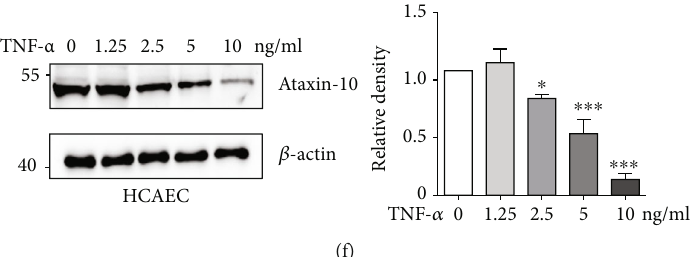
Figure 1: Expression of Ataxin-10 in endothelial cells. (a) Representative images of Western blotting for detection of the expression of Ataxin-10 in mouse tissues including adipose, aorta, brain, heart, kidney, liver, lung, spleen, and thymus. β -Actin was provided as a loading control. (b) Representative images of Western blotting for detection of the expression of Ataxin-10 in human primary vascular endothelial cells. (c, d) HUVEC or (e, f) HCAEC was stimulated with TNF- α for di ff erent time intervals and doses as indicated. Cell lysates were collected for Western blotting analysis. Quanti fi cation of the bands was carried out using Gel-Pro Analyzer software, and results were presented as “ fold changes ” at the right side of the